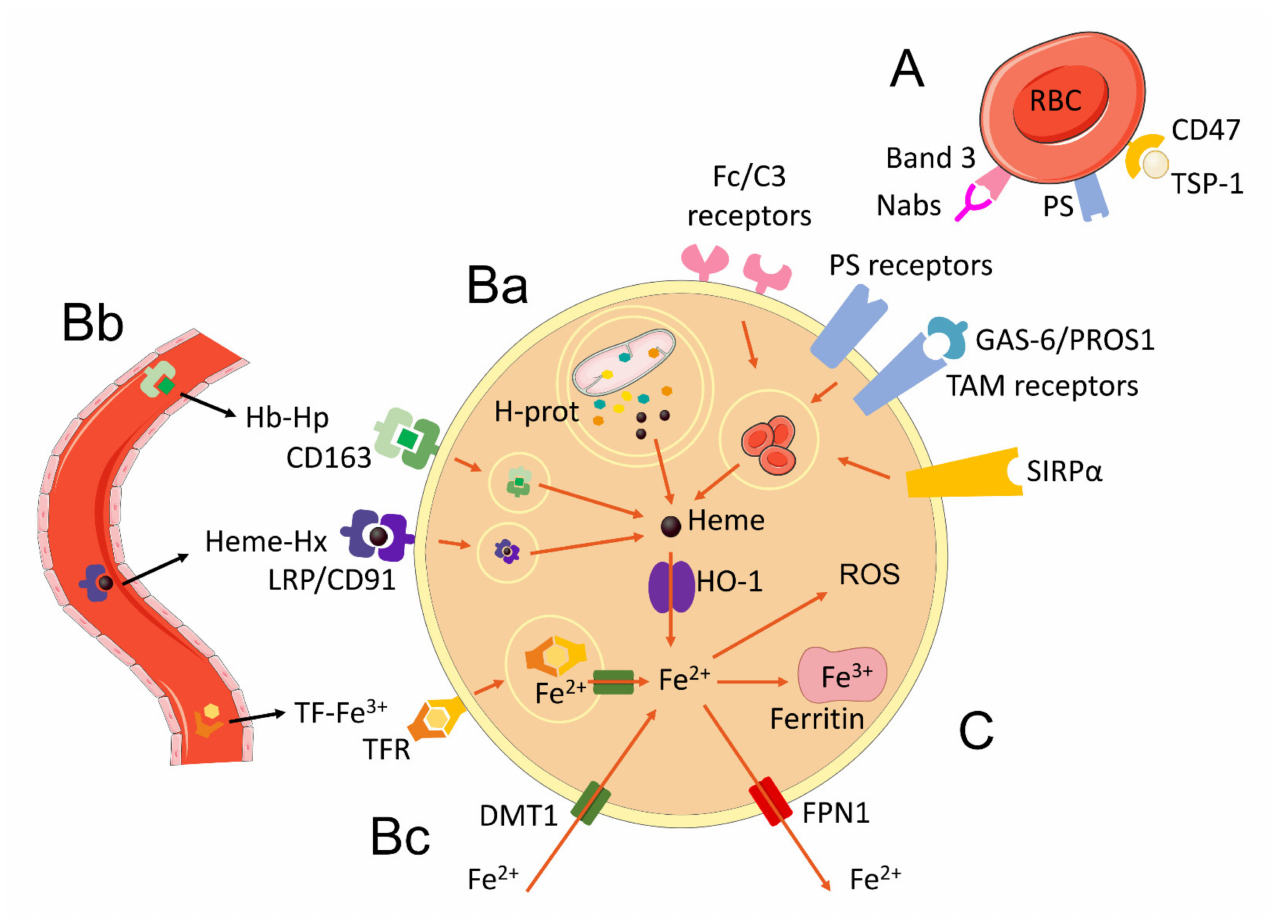
Figure 1. Major mechanisms of iron acquisition by macrophages. ( A ) Phagocytosis and recycling of senescent erythrocytes by macrophages occur through the recognition of Nabs (natural antibodies) bound to Band3 antigens and complement by Fc and C3 receptors, recognition of phosphatidylserine (PS) by PS receptors and TAM receptors bridged by GAS6 and PROS1 ligands or recognition of CD47 bound by TSP-1 by SIRP α receptors. ( Ba ) Autophagy of hemoproteins (H-prot) found free in the cytoplasm or present in mitochondria (mitophagy). ( Bb ) Endocytosis of circulating extracellular hemoglobin (Hb)-haptoglobin (Hp) and heme-hemopexin complexes through CD163 and LPR/CD91 receptors respectively. These mechanisms result in the release of heme molecules in the cytosol, which are metabolized by HO-1 and release Fe 2+ iron. Extracellular circulating transferrin (TF)- Fe 3+ complexes are recognized by transferrin receptors (TFR) and endocytosed, releasing ferric iron that is converted to ferrous (Fe 2+ ) iron and transported to the cytosol through the DMT1 receptor. ( Bc ) DMT1 receptor can also internalize extracellular free Fe 2+ ions. ( C ) Intracellular free iron can be stored in ferritin molecules in the ferric (Fe 3+ ) form or transported to the extracellular compartment through ferroportin. Free intracellular ferrous iron promotes the generation of reactive oxygen species through the Fenton reaction. Some elements in this figure use pictures from Servier Medical Art (https://smart.servier.com, last accessed on 30 March 2022) licensed under a Creative Commons Attribution 3.0 Unported License (https://creativecommons.org/licenses/by/3.0/, last accessed on 30 March